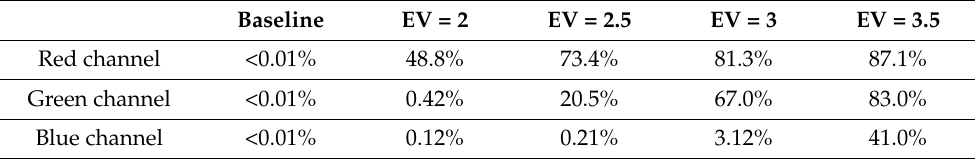
Table 1. Percentage of saturated pixels in each channel resulting from exposure simulation for S noon with EV values of 2, 2.5, 3, and